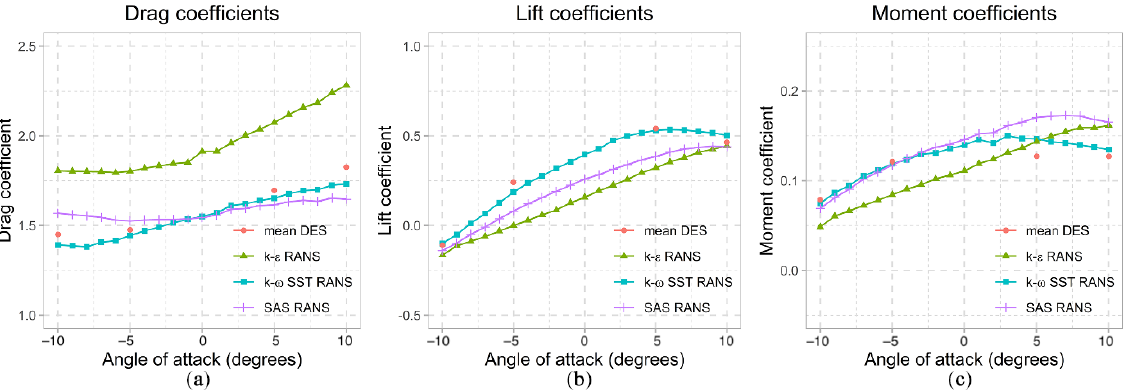
Figure 19. Comparison of aerodynamic coefficients in the turbulence model sensitivity study: ( a ) Drag coefficients; ( b ) Lift coefficients; ( c ) Moment coefficients.